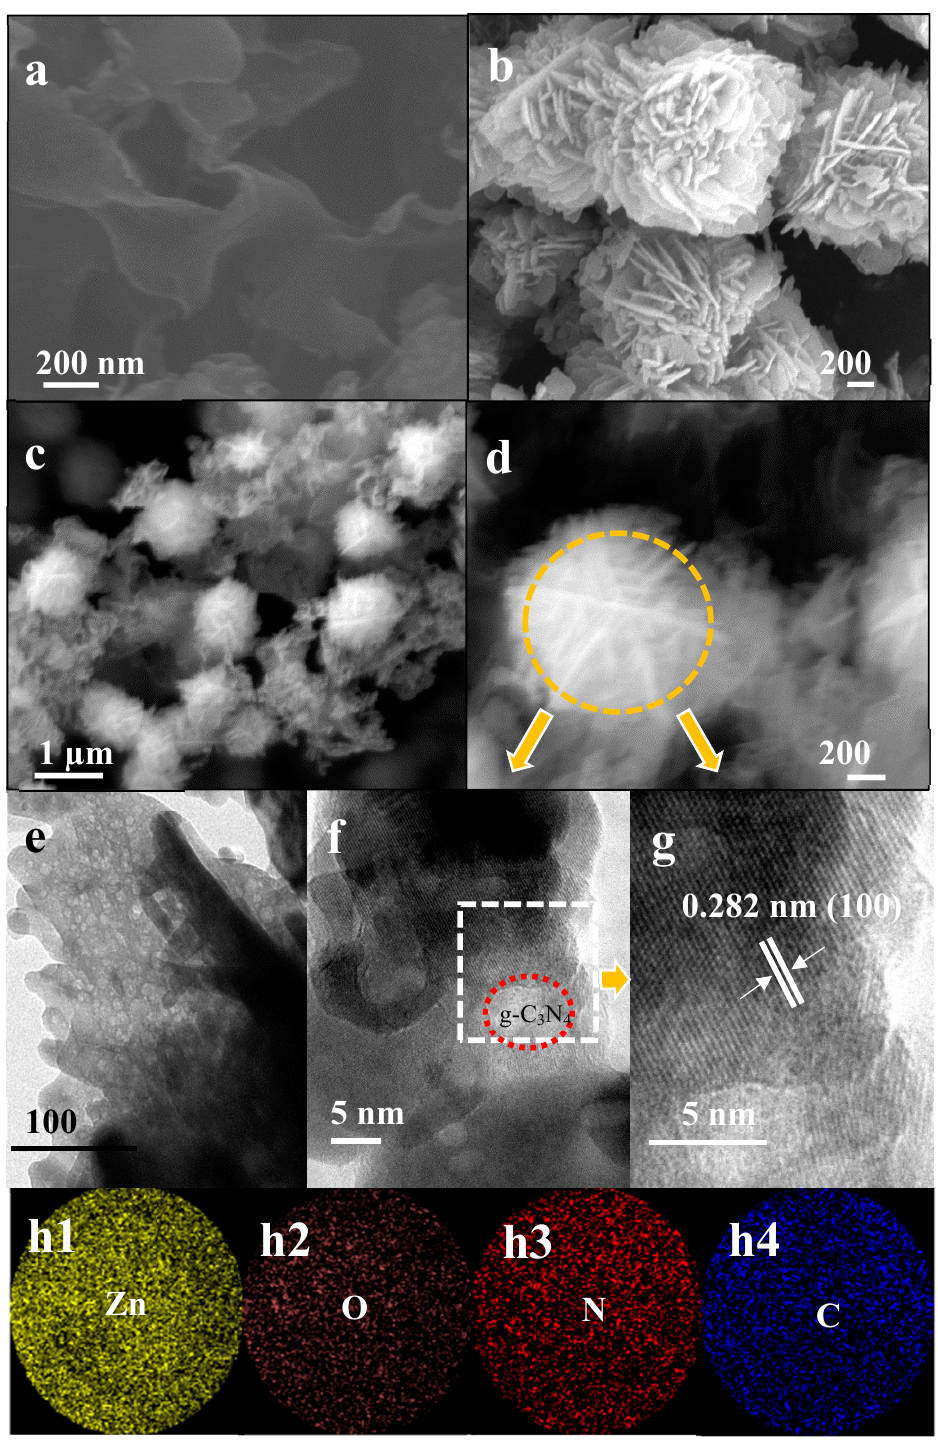
Figure 4. FESEM images of g-C 3 N 4 ( a ), pure ZnO ( b ), and CNZ-3 ( c,d ), ( e,f ) TEM and ( g ) HRTEM image of CNZ-3, ( h1,h2,h3,h4 ) elemental mapping of Zn, O, N, and C (CNZ-3).